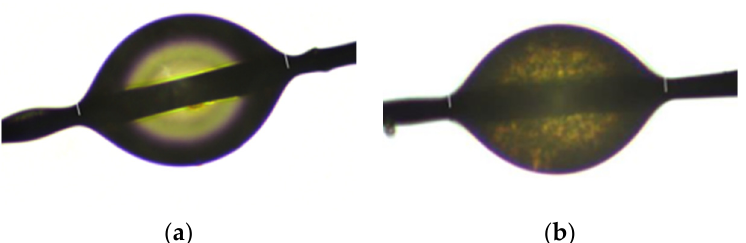
Figure 2. Influence of the annealing treatment on the microbond crystalline state: ( a ) after fast cooling; ( b ) with an annealing treatment .